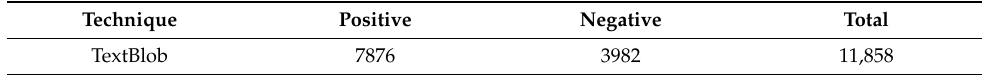
Table 2. Number of tweets for each class using